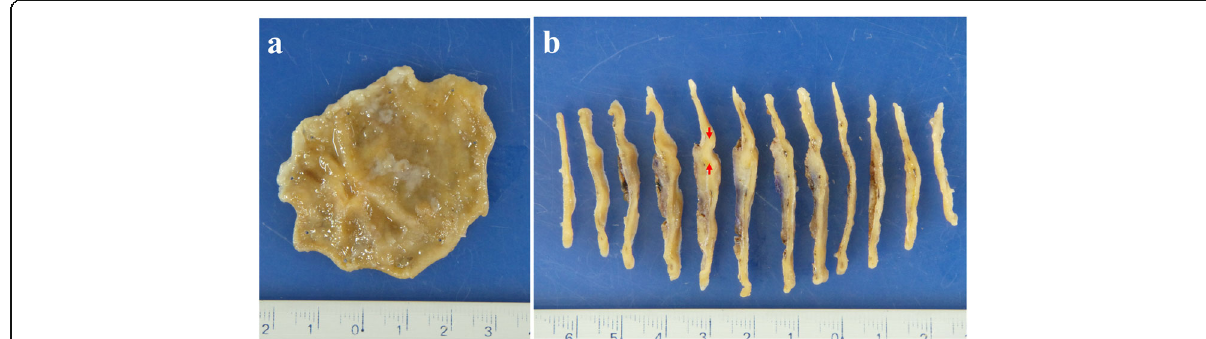
Fig. 2 Macroscopic findings of the resected specimen. A A mass with ulcer and bridging fold was shown. B Cut surface of the specimen showed small white-colored nodule in the submucosa. Red arrows showed the tumor area (maximally 6 mm in size) demonstrated in Fig. 3A